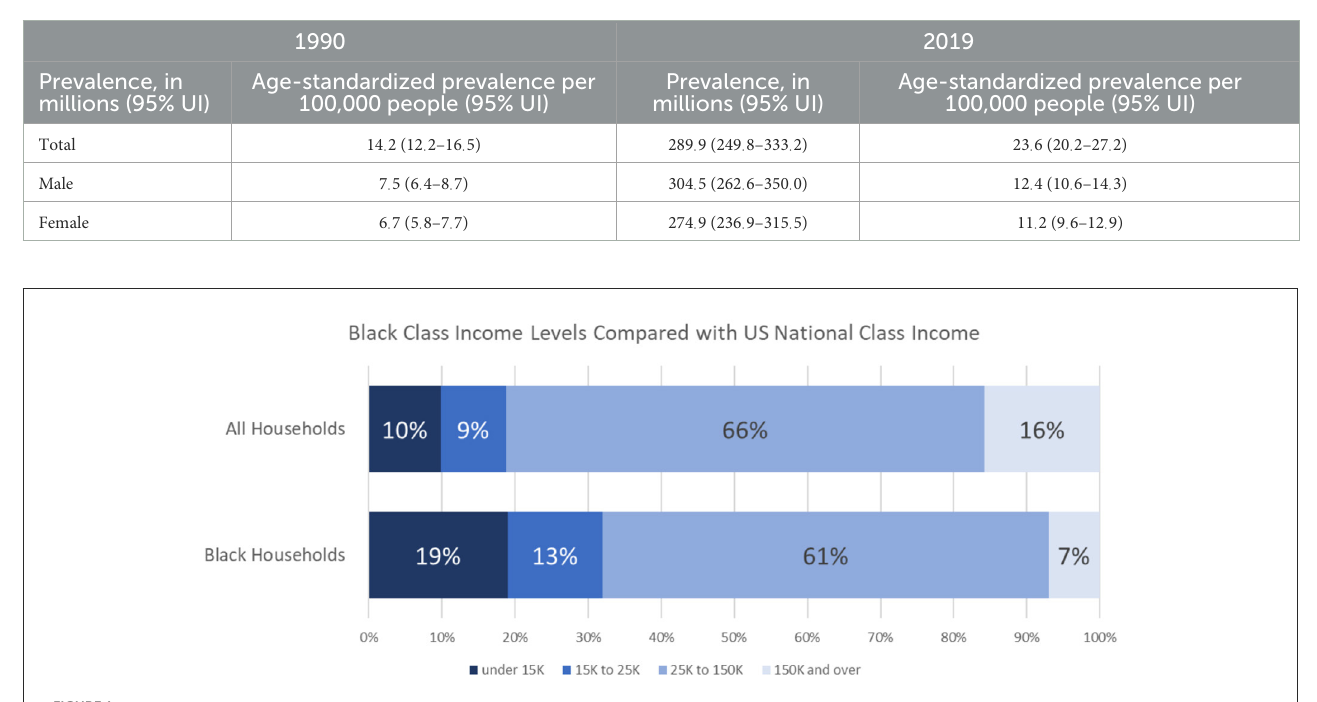
TABLE 1 Global prevalence and age-standardized prevalence for schizophrenia in 1990 and 2019 (6).